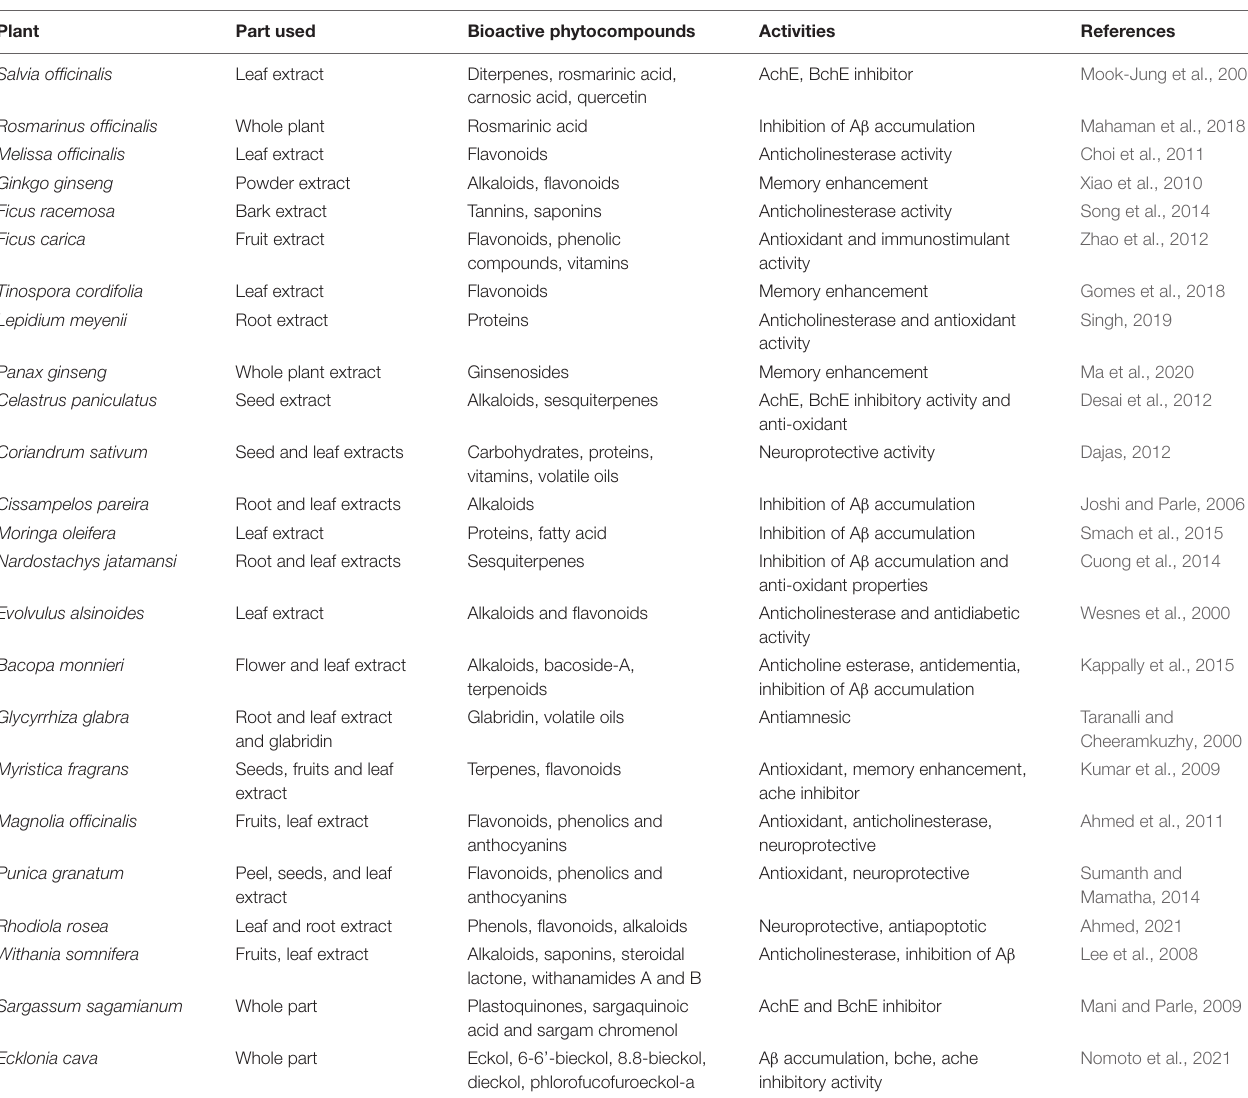
TABLE 2 | Anti- Alzheimer’s activity of medicinal